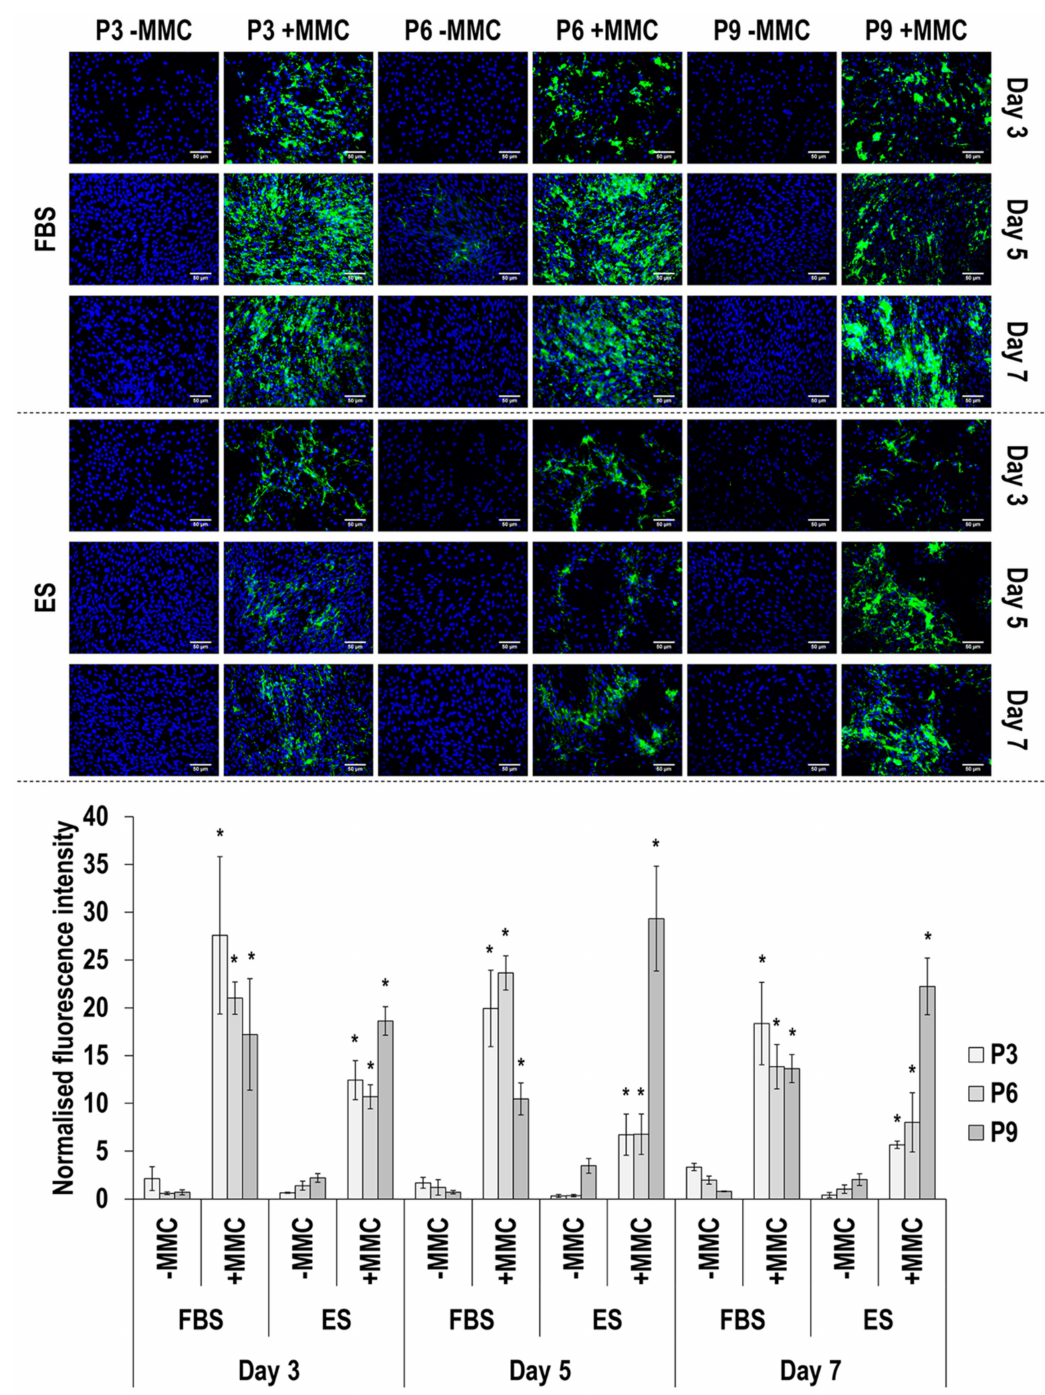
Figure 2. Immunofluorescence and image intensity analysis for collagen type I as a function of serum, passage, MMC and time in culture. Fluorescence intensity was normalised to cell number. * indicates a significant ( p < 0.05) increase in comparison to cells at passage 3, day 3, in FBS and without MMC. Scale bar: 50 µ